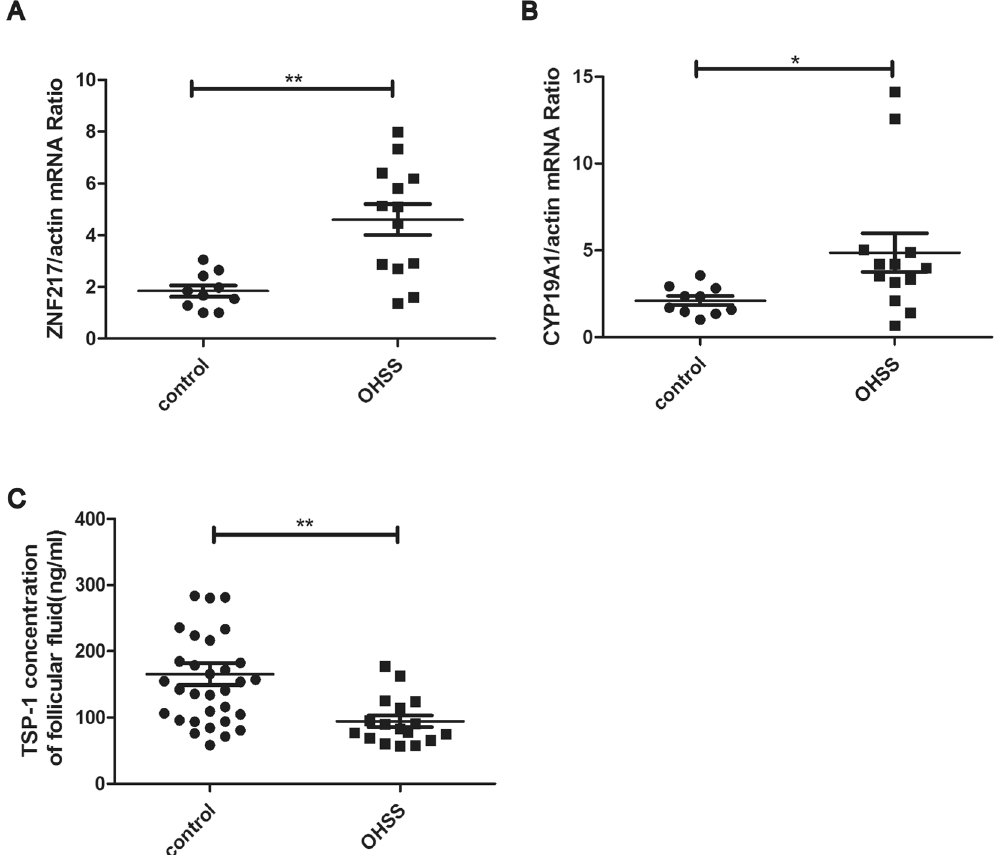
Figure 3. The expression of ZNF217 and TSP-1 of OHSS and control patients. ( A ) The expression of ZNF217 mRNA in the ganulosa cells of high risk OHSS and control patients (control n = 10, OHSS n = 13) (t = − 1.963, p = 0.064). ( B ) The expression of CYP19A1 mRNA in the ganulosa cells of high risk OHSS and control patients (control n = 10, OHSS n = 13). ( C ) The TSP-1 concentration of the follicular fluid of the high risk OHSS and control patients (control n = 32, OHSS n = 17) (t = 3.796, p < 0.001). * P < 0.05, ** P <